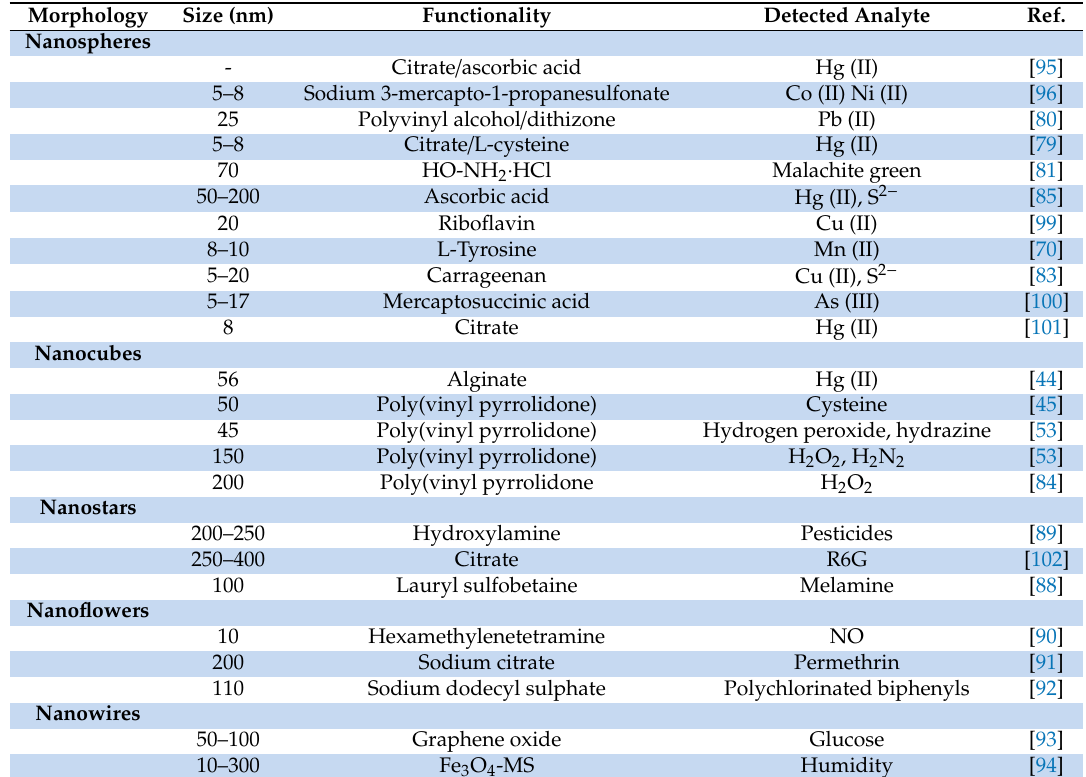
Table 1. Main morphologies reported with dimension and surface